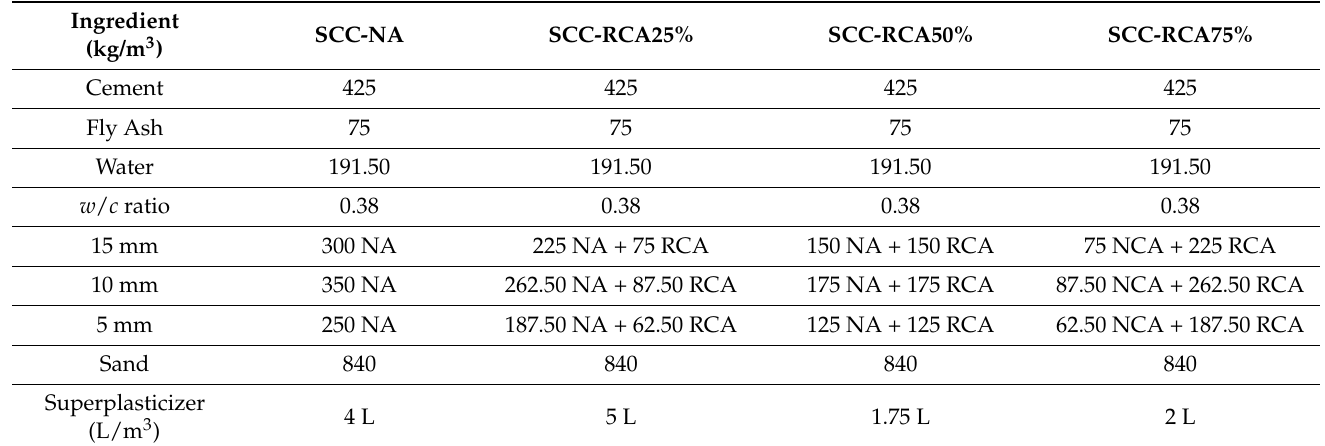
Table 1. SCC Mix